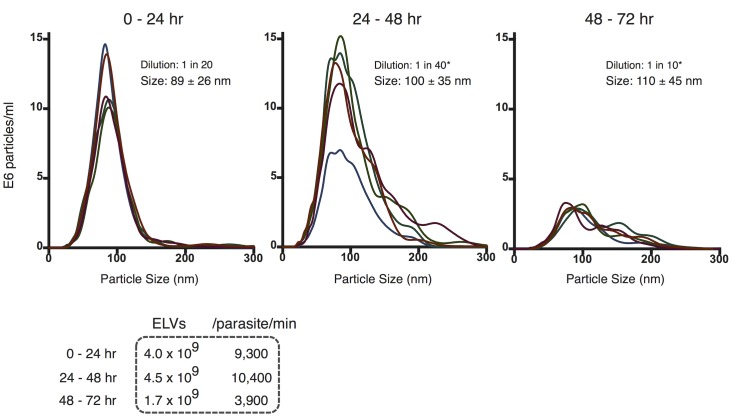
Particle tracking analysis reveals prolific larval Brugia exosome-like vesicle release rate.Profile of ELVs isolated from culture media incubated with 300 L3 parasites for successive 24 hr incubations. The size distribution of L3-derived ELVs from Day 1 (left), Day 2 (center) and Day 3 (right) incubations are shown (mean ± SD). Calculated vesicle release rates are provided in tabular format. ELV rate of release and size specificity decay in a time-dependent manner in vitro. * re-scaled based on dilution for comparison to 0–24 hour (1:20) dilution.